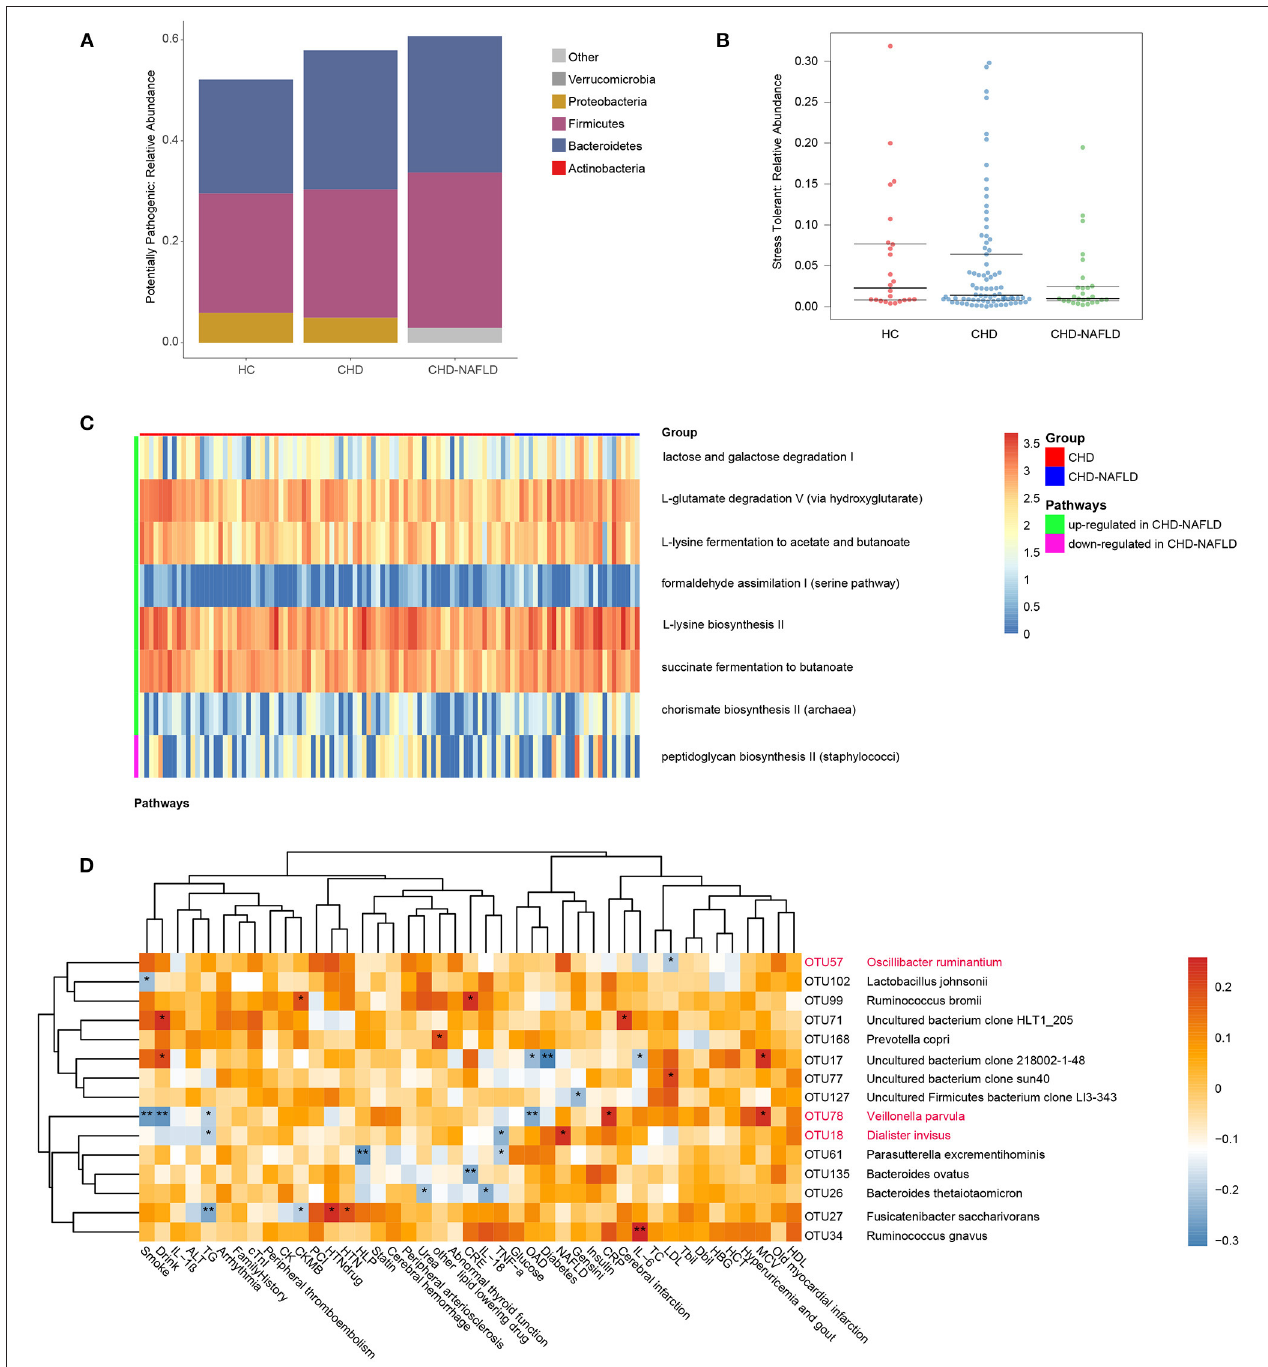
FIGURE 3 | Function prediction of gut microbiome among three groups at OTU level. (A,B) Predicted high-level phenotypes (potential pathogens and stress tolerant), calculated by BugBase. (C) Relative activity of pathways in CHD and CHD-NAFLD. (D) Correlation of the CHD-NAFLD featured gut microbes with clinical indexes. Rows: CHD-NAFLD-positive OTUs are highlighted in red, and CHD-NAFLD-negative OTUs are in black. Columns: clinical indexes. * P < 0.05, ** P < 0.01.